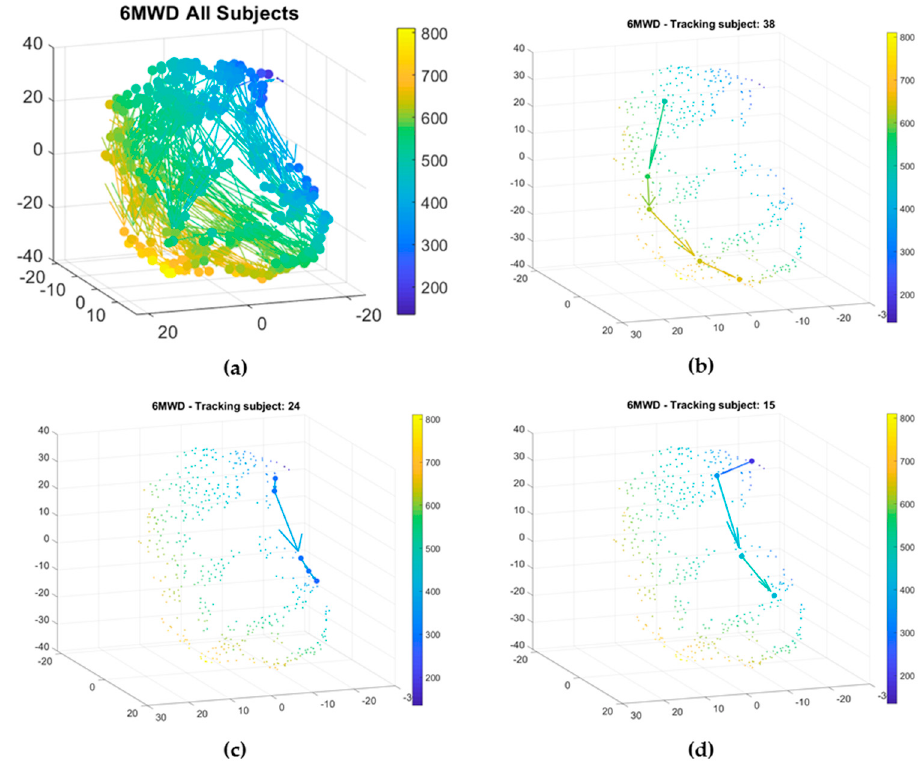
Figure 5. ( a ) Tracking all patients during the rehabilitation program (top left); ( b ) tracking of rehabilitation for patient 38. The 6MWD has increased from about 600 m (green) to more than 700 m (yellow) between the first and last session of the rehabilitation program (top right); ( c ) tracking of patient number 24. This patient shows a small difference in the 6MWD between the start and the end of the rehabilitation program (bottom left); ( d ) tracking of patient number 15. This patient shows an increase in 6MWD between baseline and the second 6MWT, stable afterwards (bottom right).